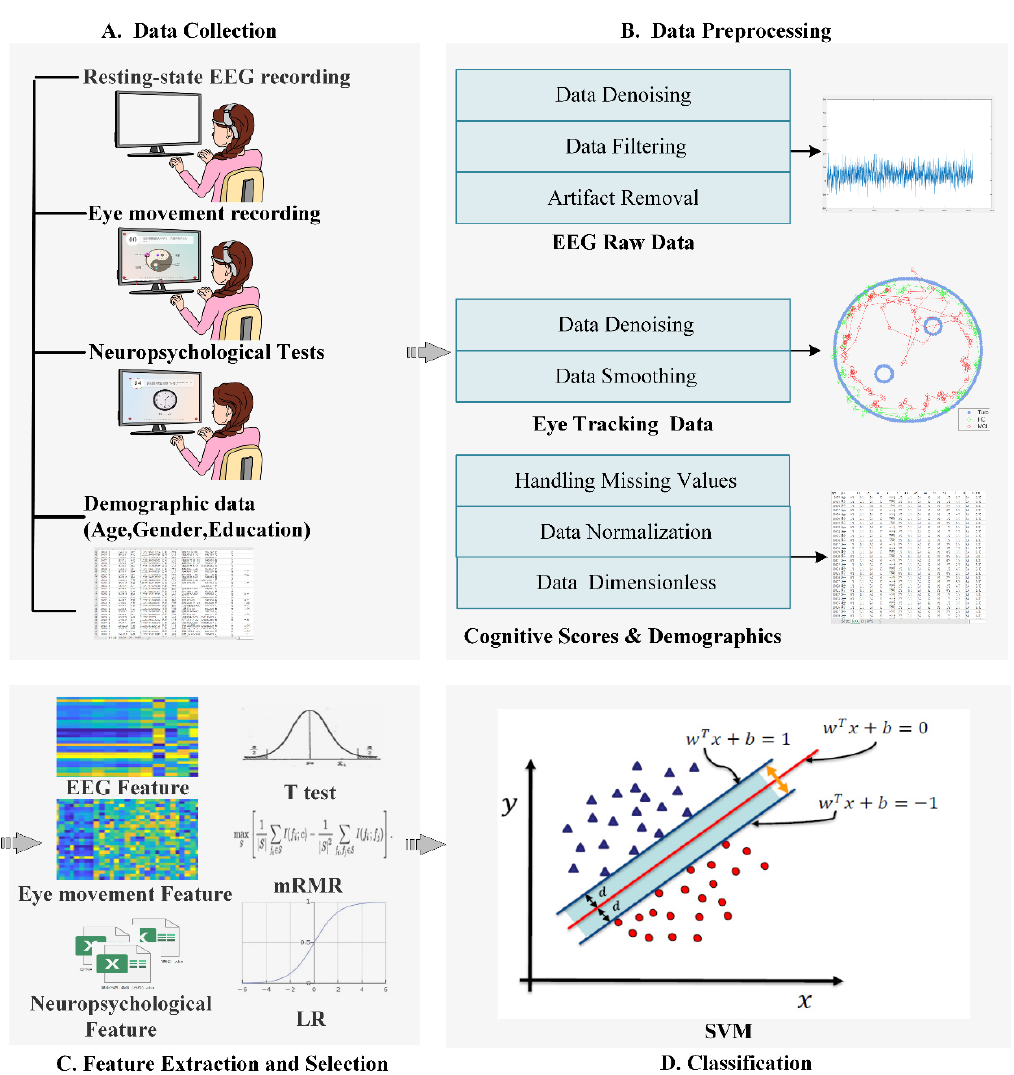
Figure 1. The flowchart of the proposed model.